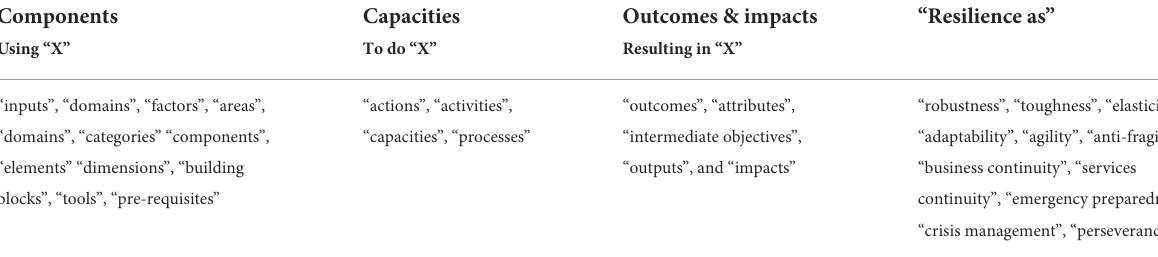
TABLE 1 Diversity in hospital resilience conceptualizations and